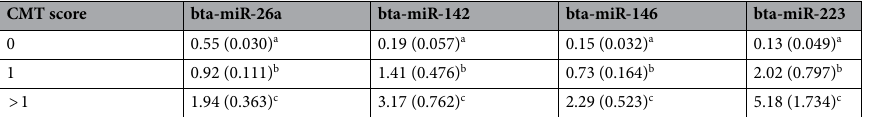
Table 3. Mean (SEM) miRNA levels in milk from mammary gland quarters with different CMT scores (n = 215 samples). Means within a column with different superscripts are different ( P < 0.001).